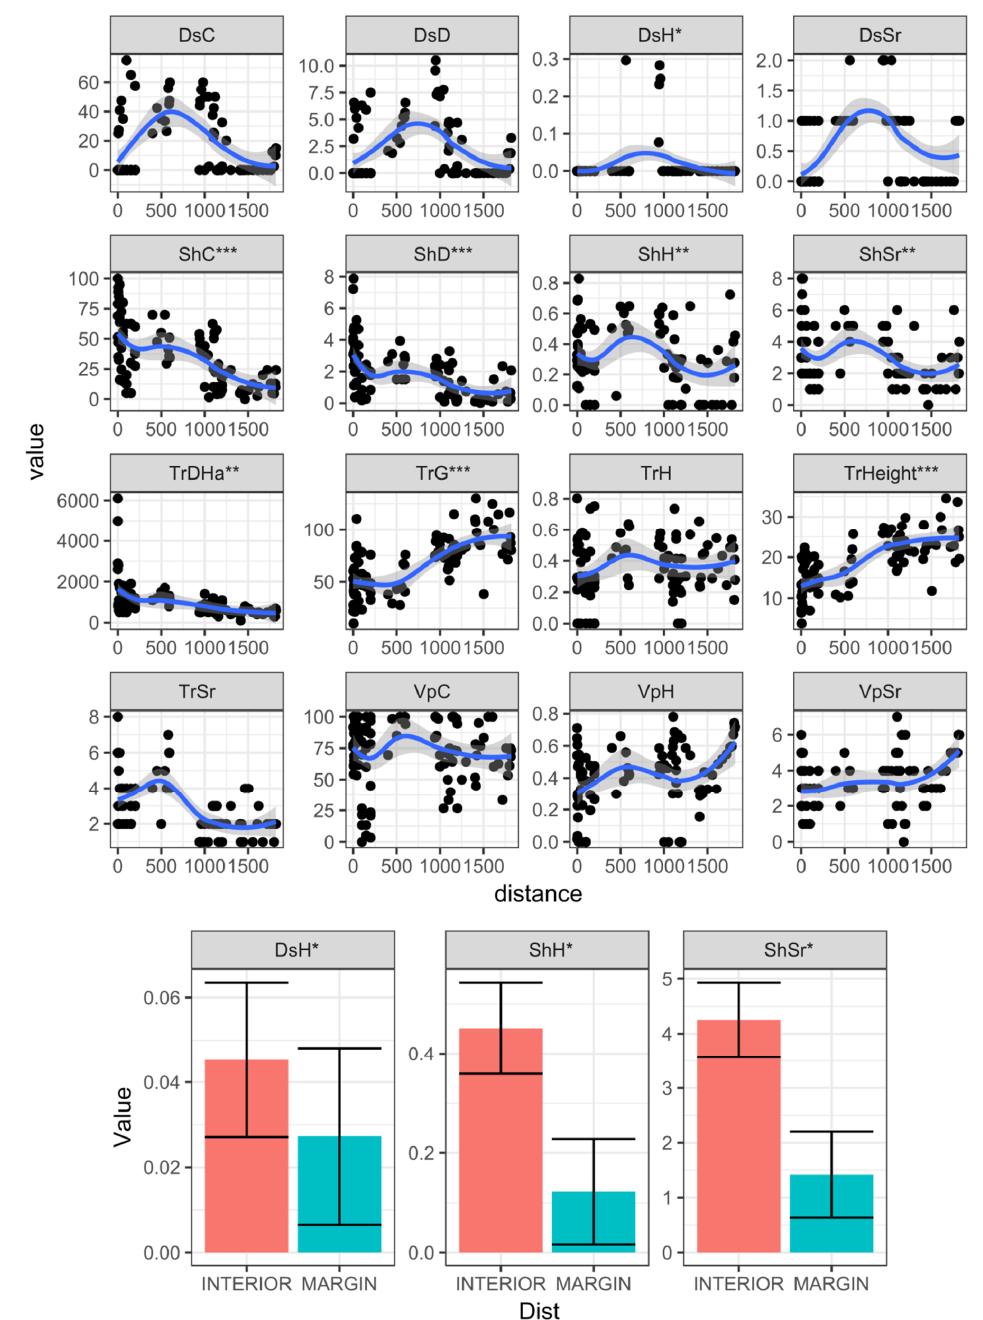
Figure 3. The relationships between the selected variables and distance were examined using LMM. The marginal means ± SE of response variables relative to the interior and margin. Explanations: * p < 0.05, ** p < 0.01, *** p < 0.001. The codes of the variables are listed in Table 1.